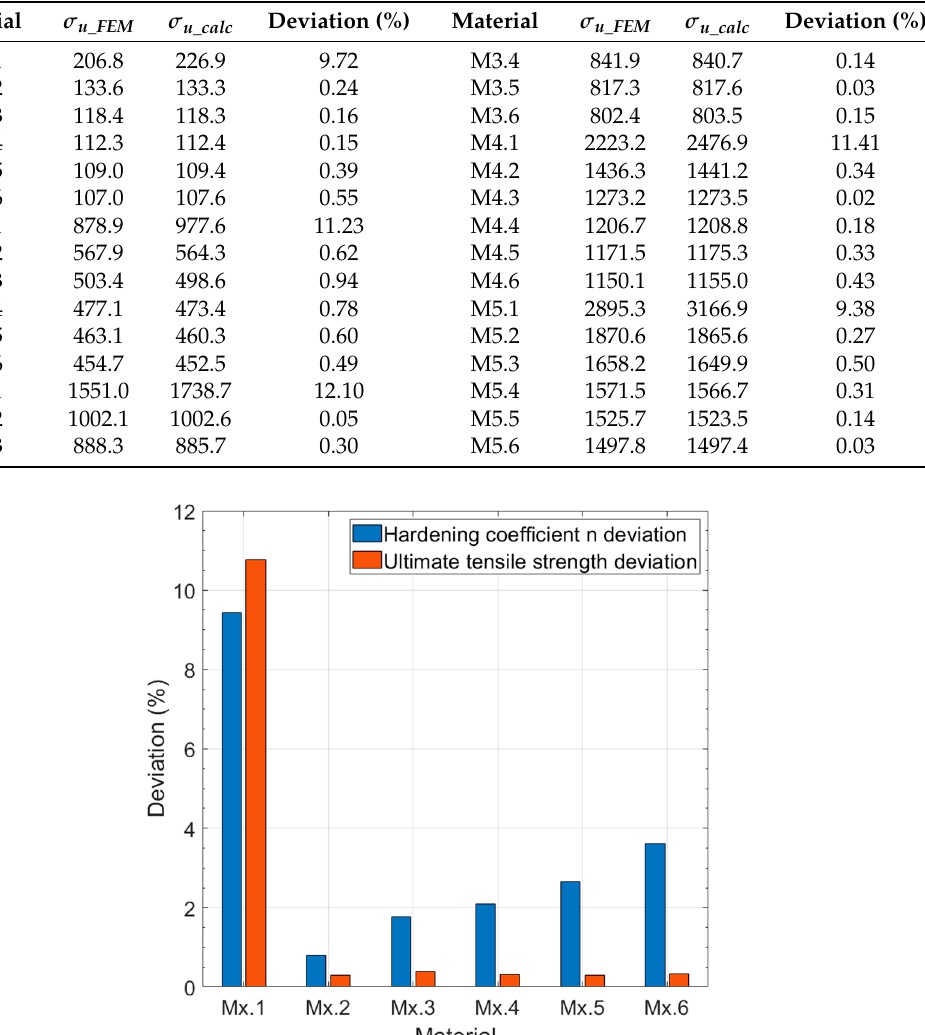
calc and σ u_calc